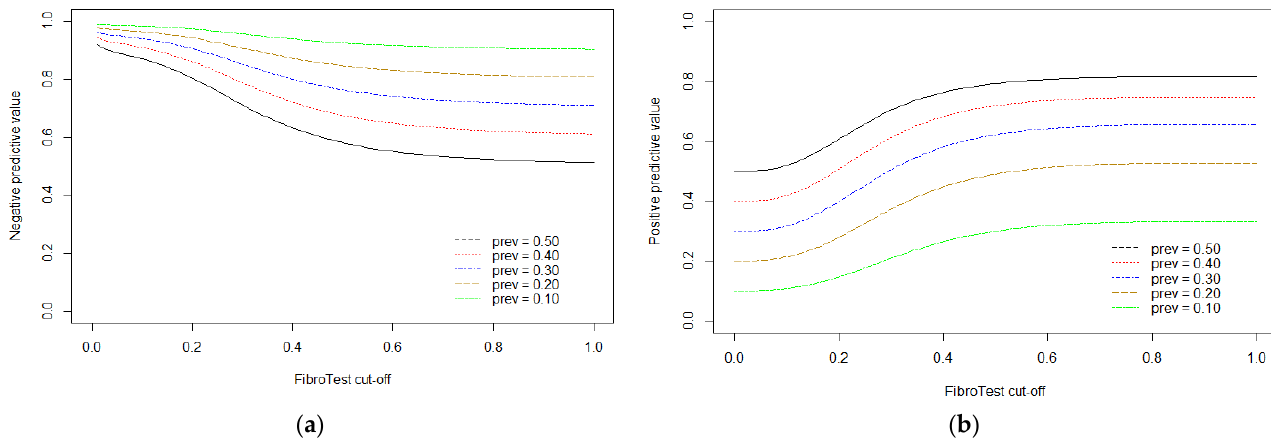
Figure 3. Plots illustrating the negative ( a ) and positive ( b ) predictive values of FibroTest for detecting advanced fibrosis at corresponding threshold values, projected by the multiple thresholds model. Each colored line represents a different prevalence setting, ranging from 10% to 50%.